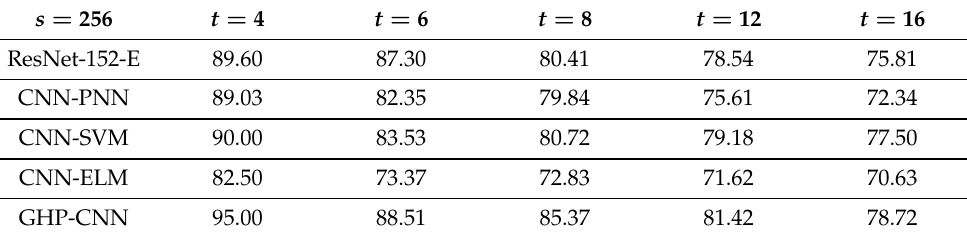
Table 3. Classification accuracy corresponding to different algorithms after category reduction with the Caltech-256